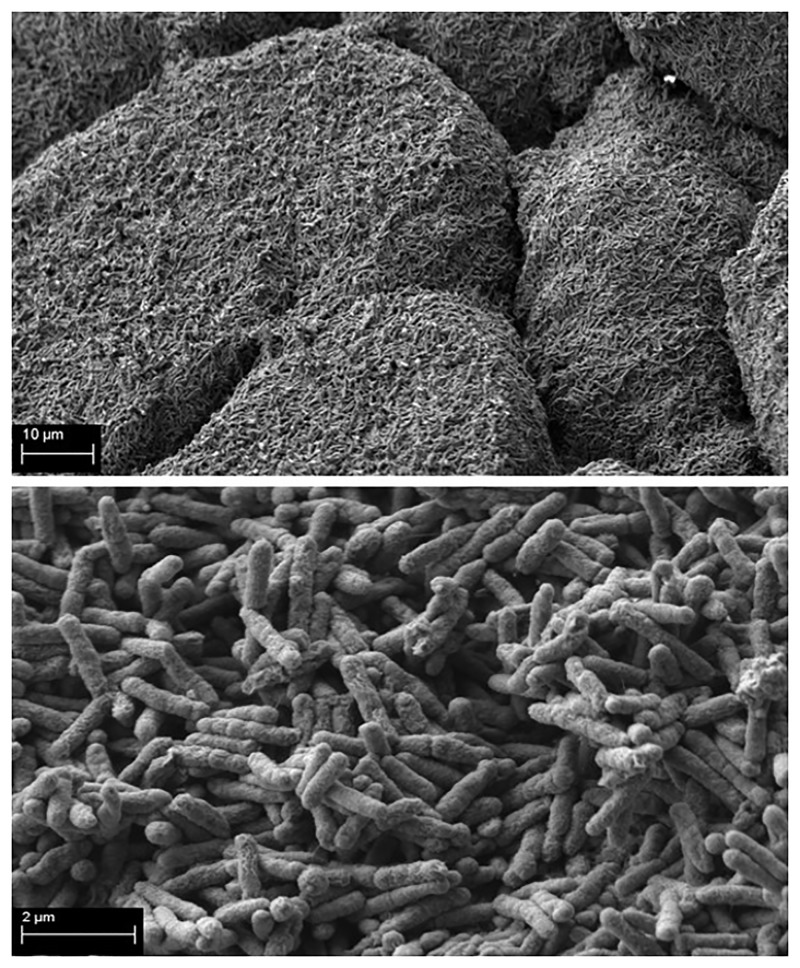
P.aeruginosa biofilm formed on HA surface.Upper part of picture–multilayer form of mature P.aeruginosa biofilm [Magn.2500x]; lower part of picture–P.aeruginosa biofilm-forming cells [Magn.20000x]. Zeiss Evo Ma SEM.